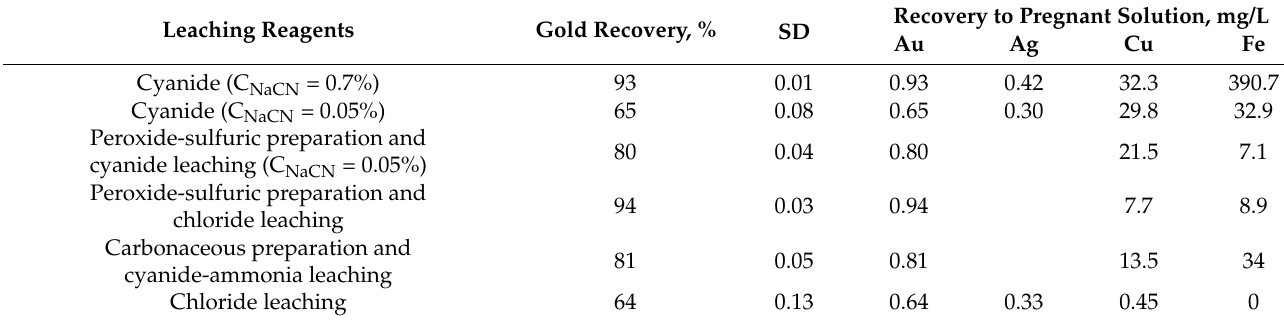
Table 2. Results of the laboratory experiments of gold